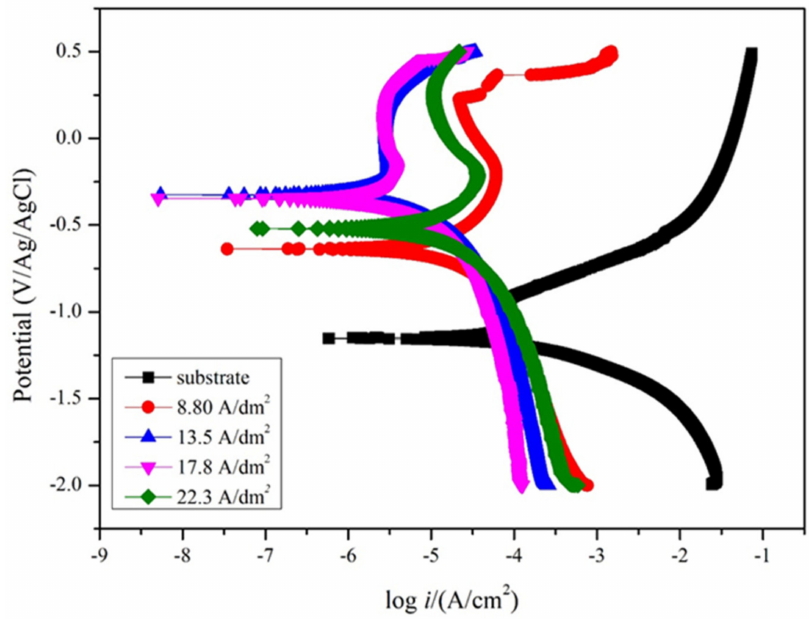
Figure 4. Potentiodynamic polarization curves of the uncoated and PEO-coated samples in 3.5 wt. % NaCl solution. PEO-coated samples formed under different current densities of ( • ) 8.8 A/dm 2 , ( (cid:78) ) 13.5 A/dm 2 , ( (cid:72) ) 17.8 A/dm 2 , and ( (cid:7) ) 22.3 A/dm 2